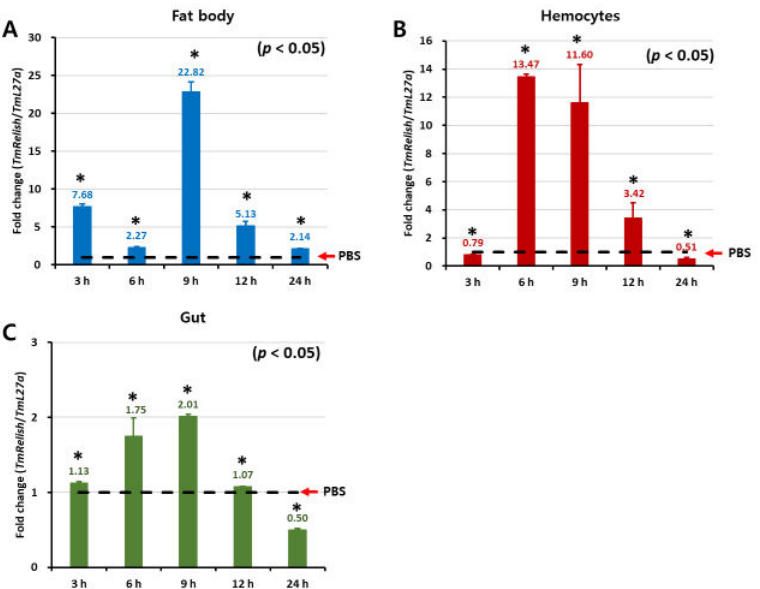
Figure 1. TmRelish mRNA expression levels in the fat body ( A ), hemocytes ( B ), and gut ( C ) upon L. monocytogenes infection. Total RNAs were isolated from young larvae (10 th –12 th instar larvae) at 3, 6, 9, 12, and 24 h post-injection. T. molitor 60S ribosomal protein L27a ( TmL27a ) was used as an endogenous control. TmRelish expression in PBS-treated larvae was normalized to 1. ‘*’ shows significant di ff erences ( p <